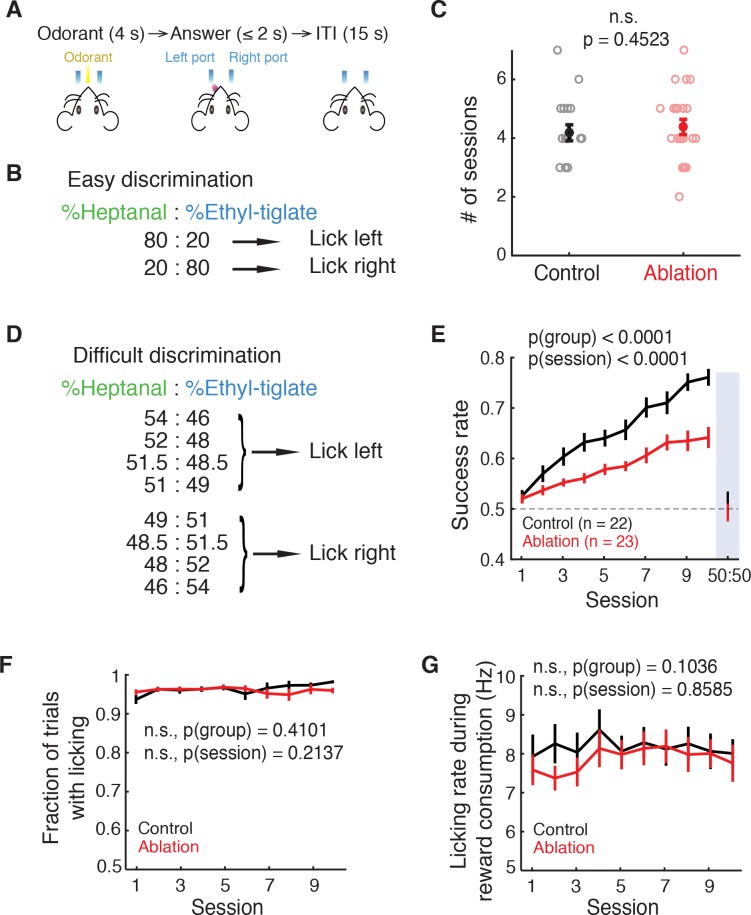
Ablation mice are impaired in difficult but not easy discrimination task.(A) Trial structure. (B) Easy discrimination task. Mice are trained to lick left in response to H80E20 (a mixture of 80% heptanal and 20% ethyl-tiglate) and lick right to H20E80. (C) Number of sessions required to reach expertise (>80% success rate) in the easy discrimination task. There is no significant difference between control (n = 22) and ablation (n = 23) groups (p=0.4523, Wilcoxon rank sum test). Learning curves are not shown since each animal was trained until expertise, resulting in varying durations of training. (D) Difficult discrimination task. One of the eight mixtures is presented pseudorandomly in each trial. (E) Fraction of correct trials over 10 sessions in the difficult discrimination task. Ablation animals exhibit impaired learning compared to control animals (p(group)<0.0001, p(session)<0.0001, two-way ANOVA). Both groups had equal and chance-level success rate in the test session with identical H50E50 mixtures, indicating that they were using odorants to guide their choice (described in Results). (F) Fraction of trials with answers (correct or incorrect) throughout the difficult task sessions. There is no difference between control and ablation (p=0.4101, two-way ANOVA). (G) Control and ablation had comparable lick rates during reward consumption (p=0.1036, two-way ANOVA). All error bars: mean ±S.E.M.